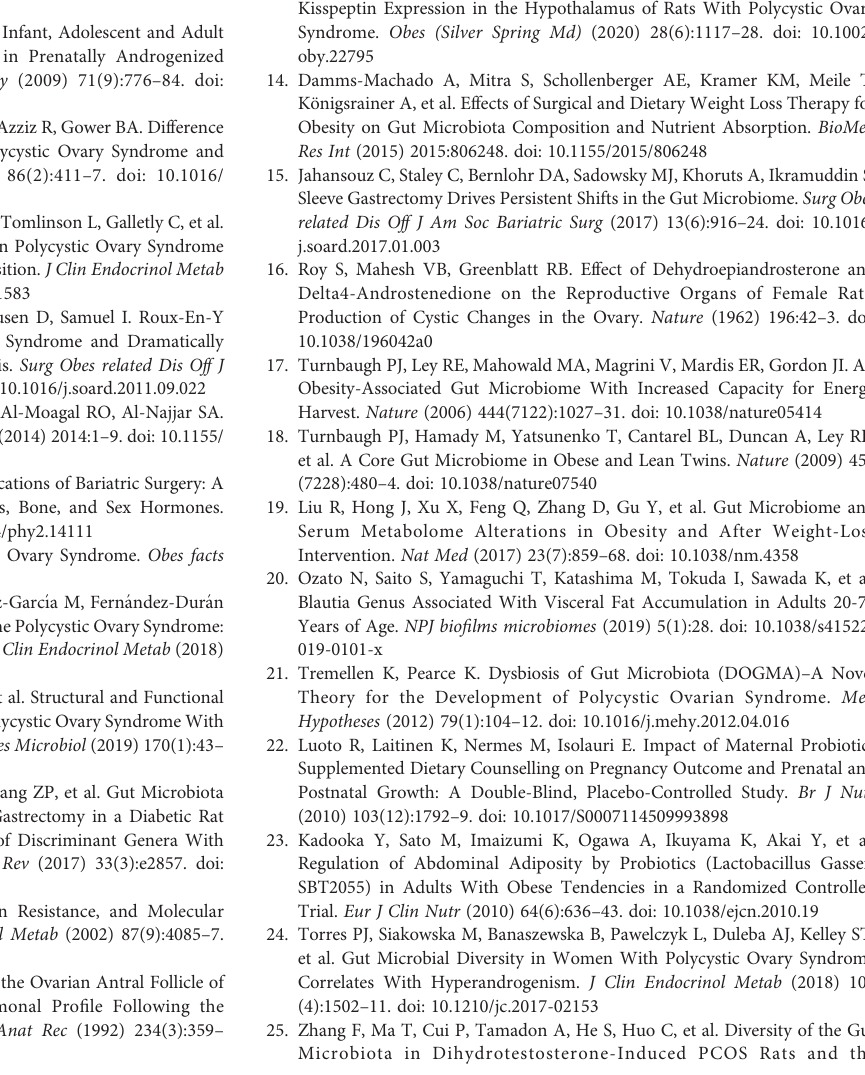
Supplementary Figure1 | EffectsofSG onshiftsin gutmicrobiota. (A) a diversity analysis using Goods_coverage diversity index. (B) b diversity analysis using Unweighted UniFrac ANOSIM analysis and principal coordinates analysis (PCA) of bacterial community composition using the unweighted UniFrac metric at the genus level. (C) Spearman ’ s correlation analysis of differential bacterial groups at the genus level. (D) PCA between DHEASg and DHEASh groups and between DHFSg and DHFSh groups. Supplementary Figure 2 | Effects of sleeve gastrectomy (SG) on the alterations in gut metabolite composition. (A) Principal coordinates analysis of fecal metabolites. (A) CON, DHEA, and DHF; (B) DHEAsg and DHEASh; (C) DHFSg and DHFSh. (B) OPLS-DA analysis. (A) permutations in DHEASg and DHEAsh; (B) OPLS-DA plot between DHEASg and DHEAsh groups; (C) permutations in DHFSg and DHFSh; d OPLS-DA plot between DHFSg and DHFSh groups. Supplementary Figure 3 | Changes in body weight before (A) and after (B) surgery. *p < 0.05. **p < 0.01. ***p < 0.001. Supplementary Information | Supplementary methods